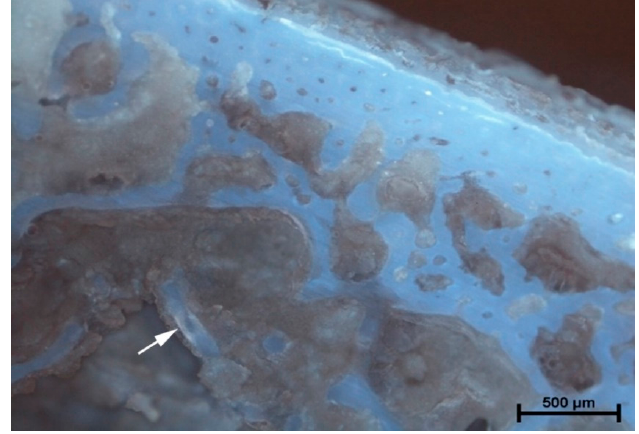
Figure 3. Rotation of 800 rpm (without cooling). Moderate destruction of the bone tissue and bone marrow. Visible debris of bone trabecular architecture and bone marrow (arrow).